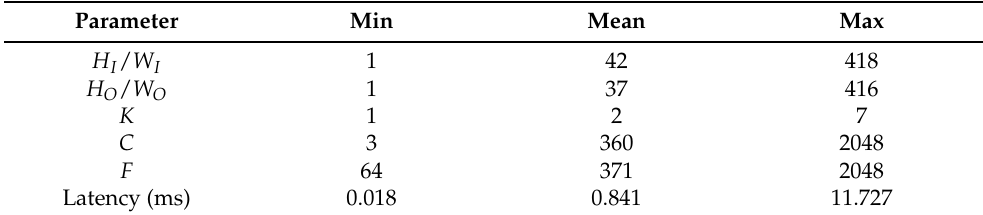
Table 3. Dataset for the evaluation of the layer-wise latency on an FPGA.